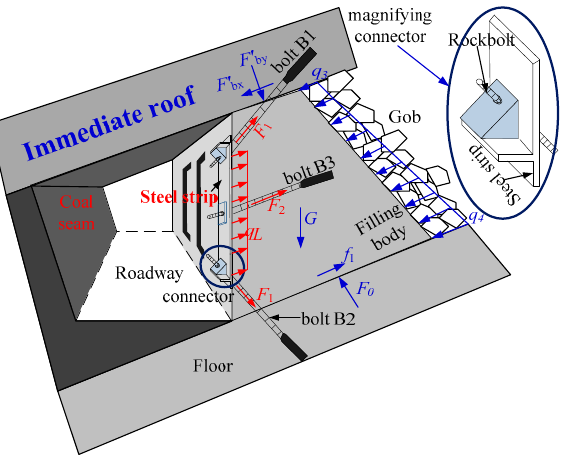
Figure 11. Filling body–truss support structure beside remaining roadway along gob.